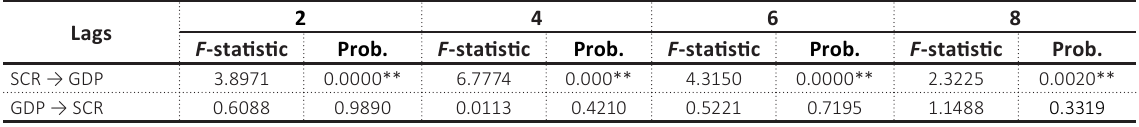
Table 4. Pairwise Granger causality test results